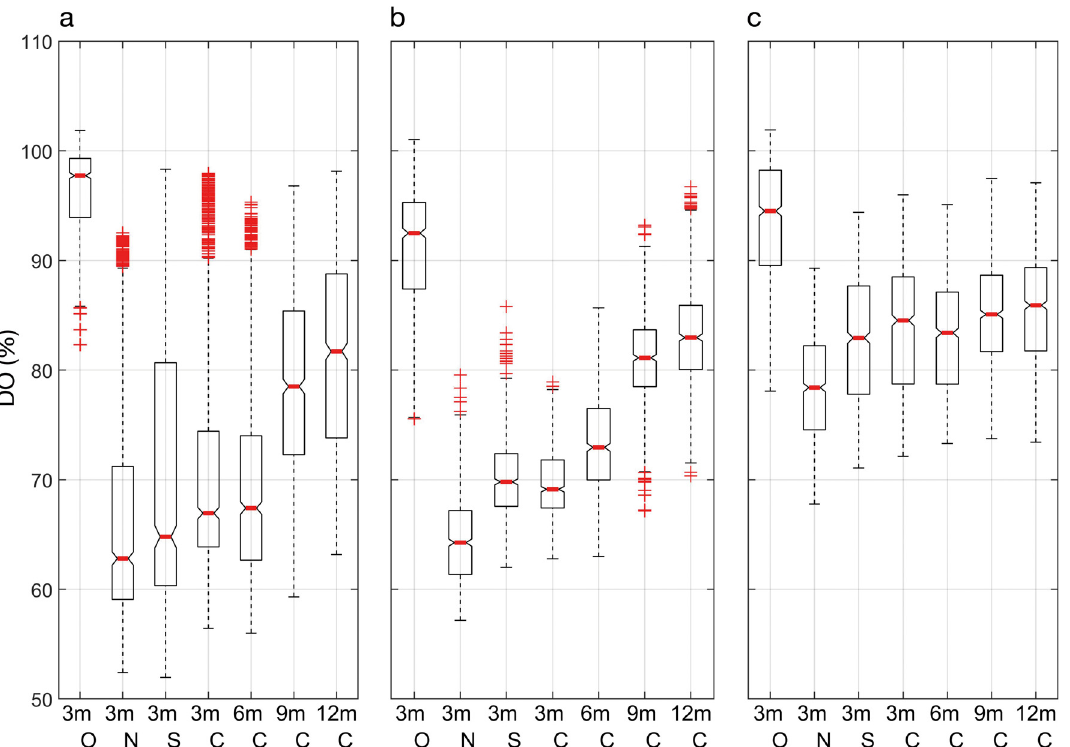
Fig. 8. Boxplot representations of oxygen levels at Fornes, showing the combined oxygen data collected between (a) 02 July 17:00 h and 03 July 09:00 h, (b) 03 July 20:00 h and 04 July 09:00 h and (c) 04 July 17:00 h and 05 July 09:00 h. The boxplots show the median DO (red line inside box), the lower edge of the box represents the 1st quartile (Q1) and the upper edge the 3rd quartile (Q3). The whiskers extends to Q1 minus 1.5 times the interquartile range (IQR), and to Q3 + 1.5 IQR. Data outside of the whiskers are measurements that exceed these limits (red crosses). The depth of the sensors is given on the x -axis with their positions. O: outside; N: north; S: south; C: centre of the